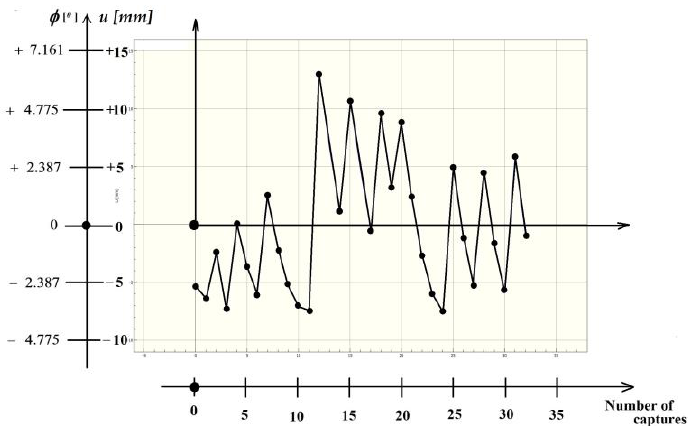
u of the point. P , respectively, 1 0